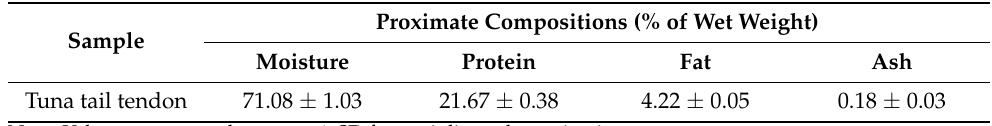
Table 1. The proximate compositions of the tail tendon of tuna ( Katsuwonus pelamis ). Sample